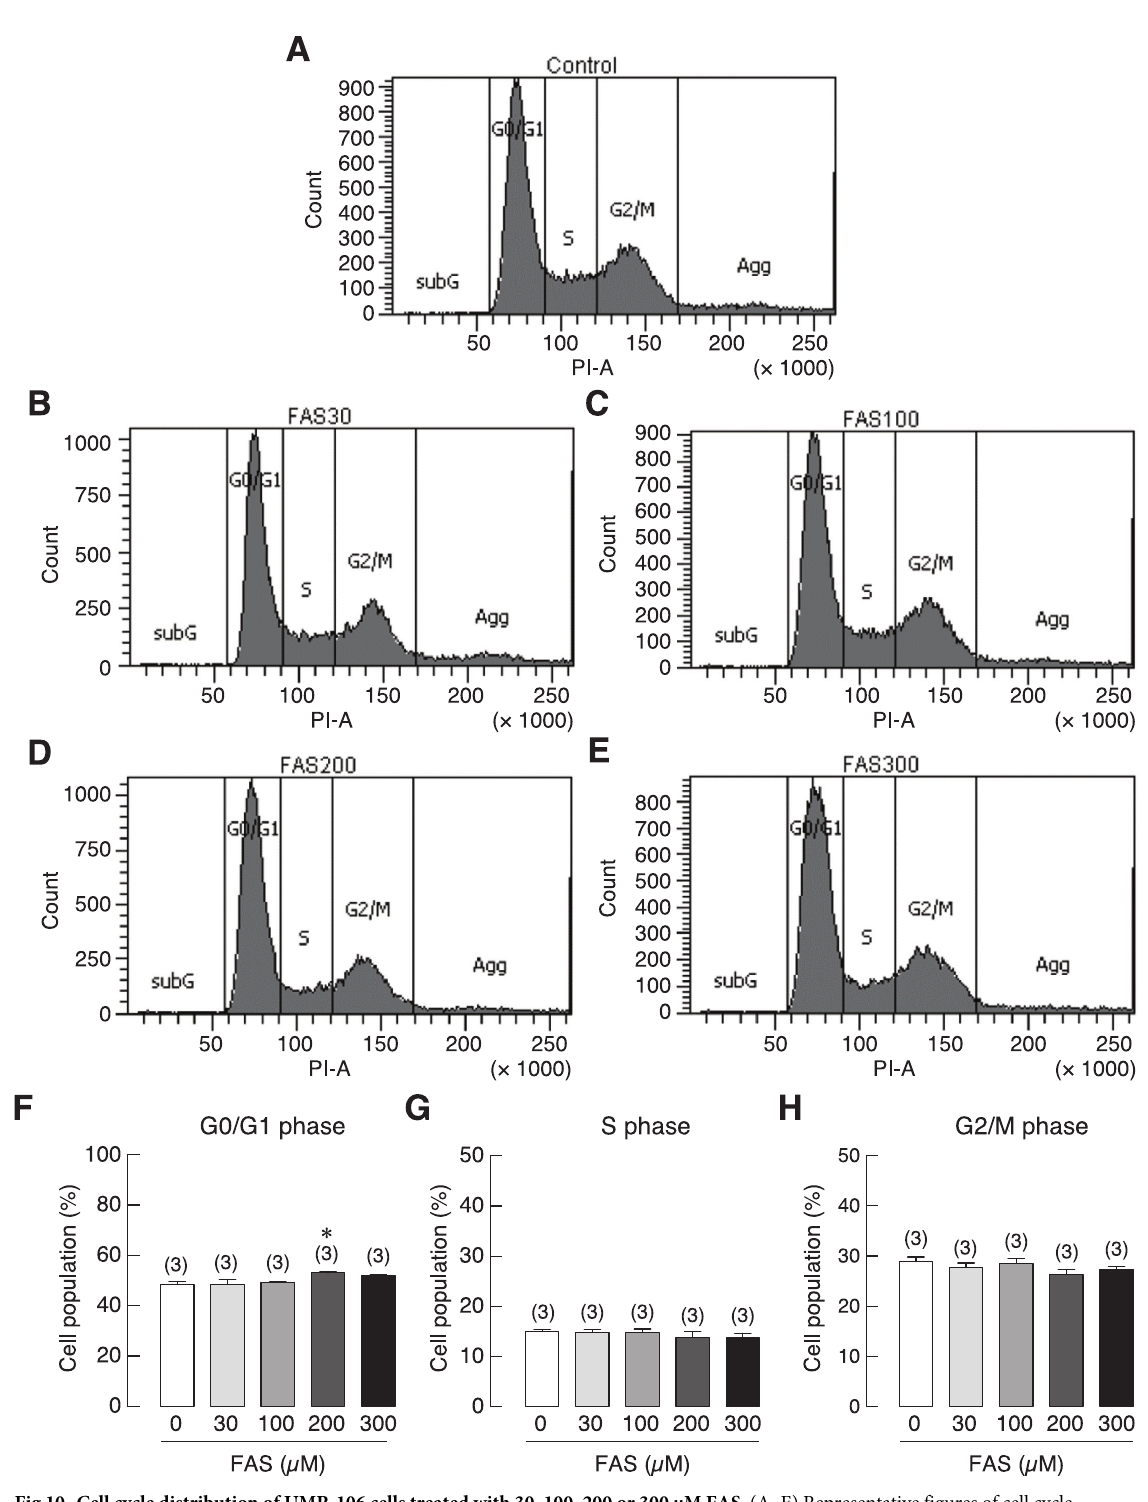
Fig 10. Cell cycle distribution of UMR-106 cells treated with 30, 100, 200 or 300 μ M FAS. (A–E) Representative figures of cell cycle distribution as determined by flow cytometry. Quantified data showing percent cell distribution in G0/G1 phases (F), S phase (G) and G2/M phases (H). � P < 0.05 as compared to control group (0 μ M); PI, propidium iodide.